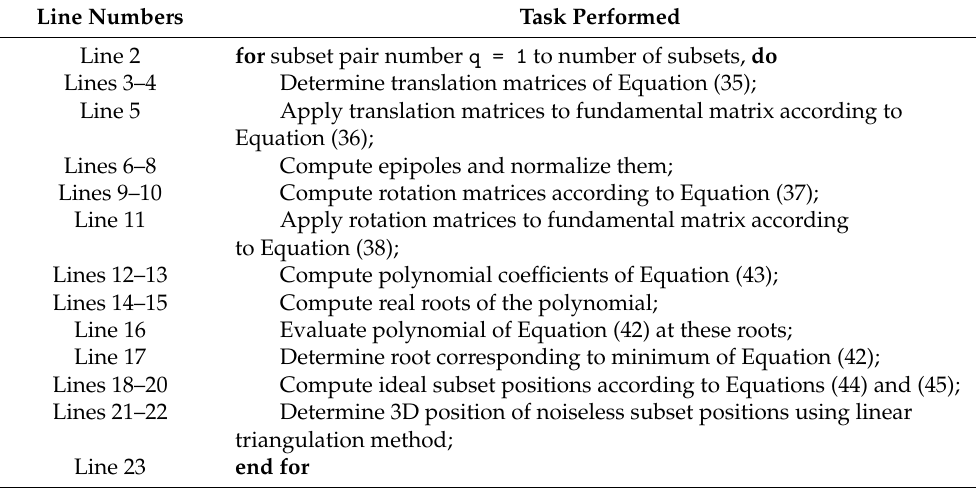
Table 14. Triangulation algorithm